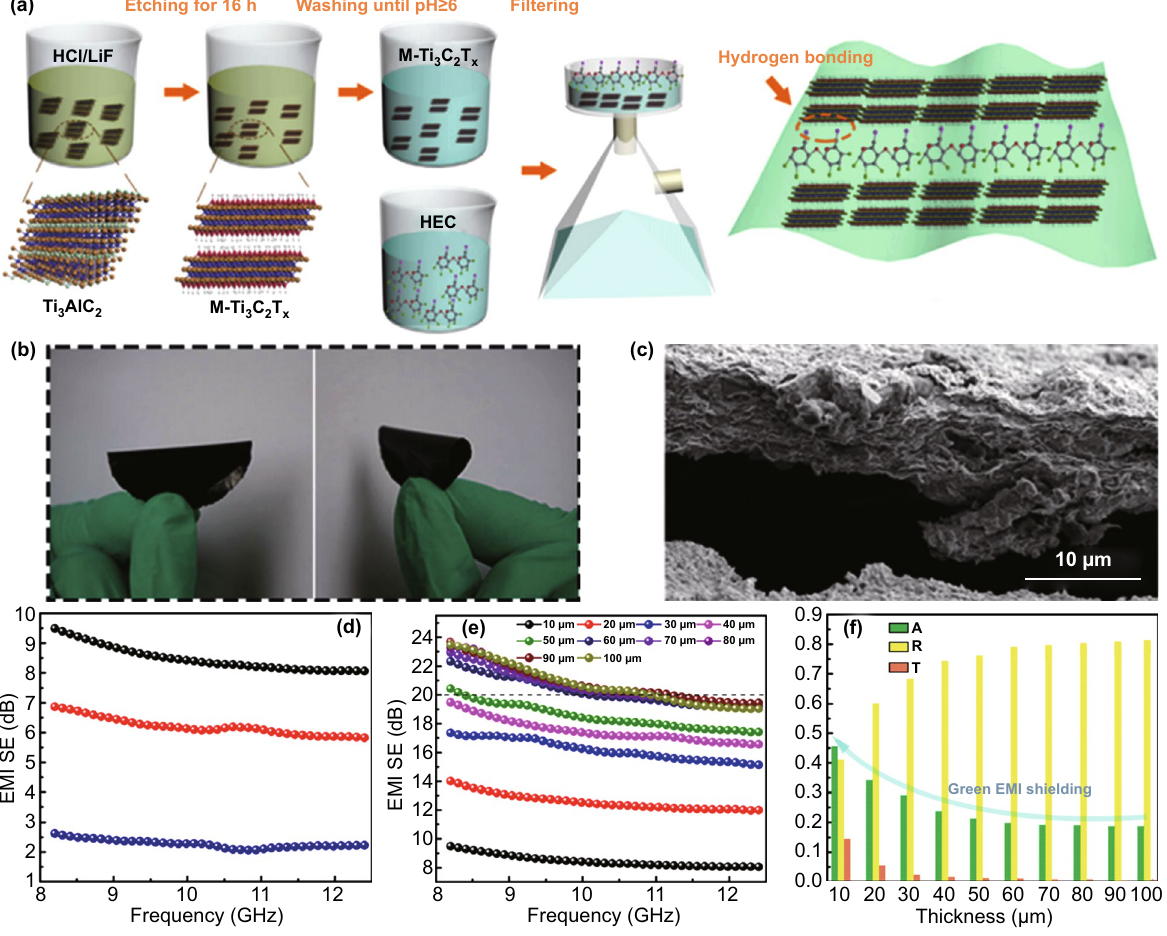
Fig. 5 a Schematic illustration of fabricating M‑Ti 3 C 2 T x /HEC composite film. b Digital image of M‑Ti 3 C 2 T x /HEC composite film. c Cross‑ sectional SME images of M‑Ti 3 C 2 T x /HEC composite film. d EMI SE T , SE A and SE R of M‑Ti 3 C 2 T x /HEC composite film at 10 µ. e EMI SE of M‑Ti 3 C 2 T x /HEC composite film at different stacking thicknesses. f The average A, R and T of M‑Ti 3 C 2 T x /HEC composite film at different stack‑ ing thicknesses. Reproduced with permission from Ref. [80]. Copyright 2019,